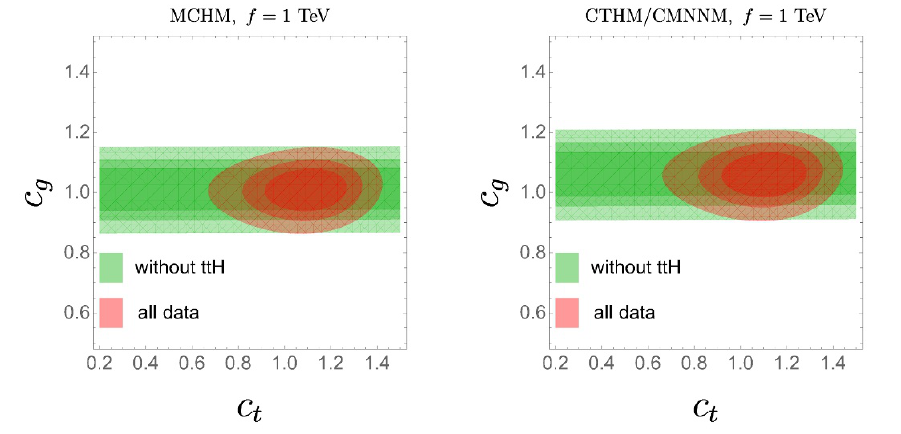
Figure 6 . The global (cid:12)t on the values of c t and c g for MCHM (left) and CTHM/CMNNM (right). The green regions (from dark to light) are the 1 (cid:27) , 2 (cid:27) , and 3 (cid:27) bounds without the tth measurements corresponding to (cid:31) 2 < (2 : 9 ; 5 : 99 ; 11 : 83). The red regions (from dark to light) are the 1 (cid:27) , 2 (cid:27) , and 3 (cid:27) allowed regions corresponding to (cid:31) 2 < (2 : 9 ; 5 : 99 ; 11 : 83) including all the Higgs signal measurements listed in the table